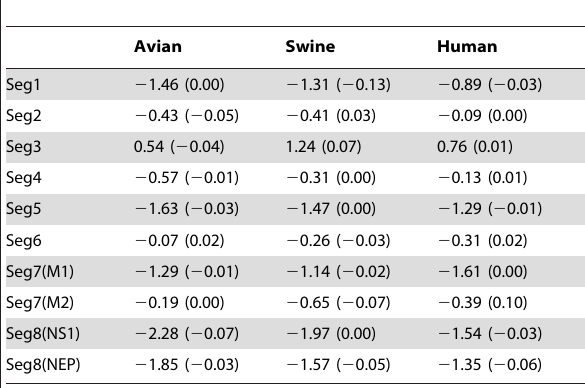
Table 1. Average z-scores for ( + ) and ( 2